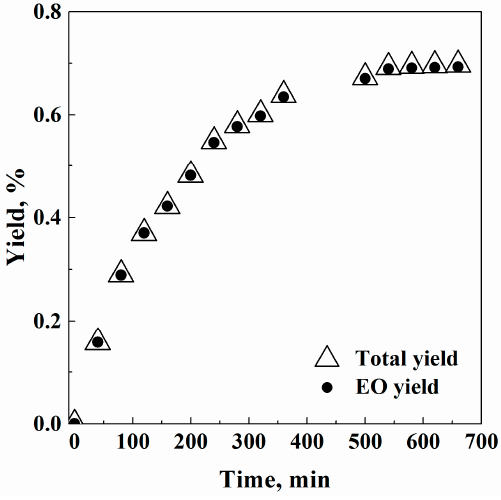
Figure 2. Representation of SFE total yield and EO yield versus time: 100 bar and 40 ◦ C. Table 1. Gas chromatography–mass spectrometry (GC-MS) analysis on SFE extracts obtained at 100 bar and 40 ◦ C.